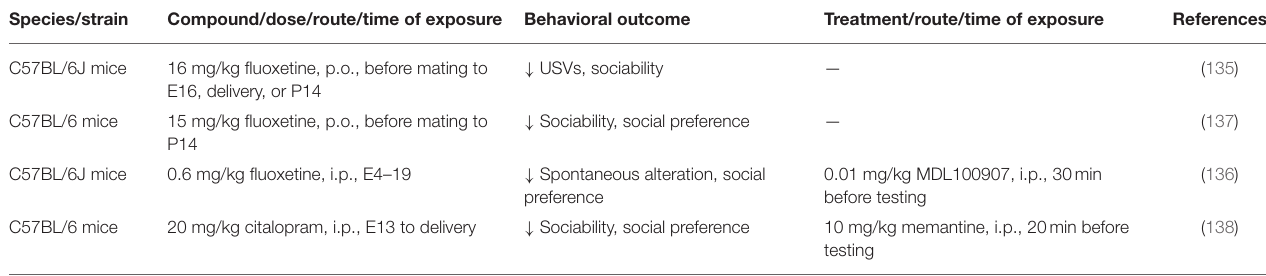
TABLE 2 | Rodent models of prenatal exposure to SSRIs.